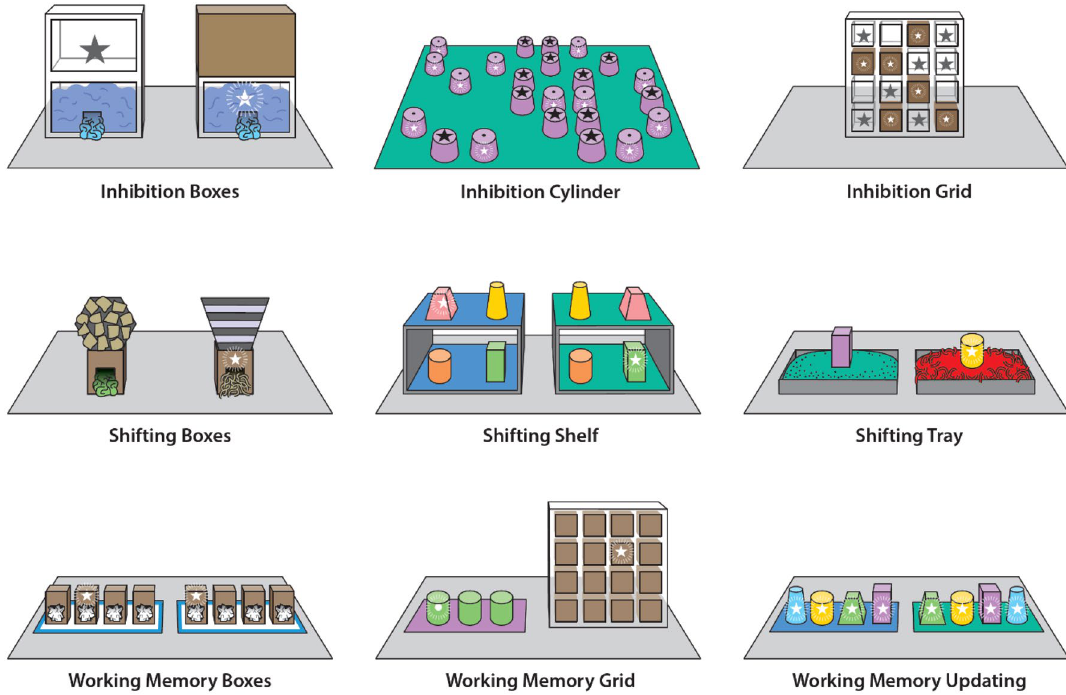
Figure 1. The nine executive functions tasks administered. In the Inhibition tasks, subjects were supposed to choose an opaque container (box, cylinder, or grid cell) with a non-visible reward over a transparent one with a visible but inaccessible reward. In the Shifting Boxes and Shifting Tray tasks, subjects were required to overcome a fixation on a previously relevant stimulus dimension and focus on another dimension. In the Shifting Shelf task, subjects had to switch between two different target cups depending on the context (i.e., the shelf they were choosing from). The WM Boxes and WM Grid tasks required subjects to remember the location of a reward over a short period in which they faced interference from a secondary task. In the WM Updating task, subjects had to remember their previous choices to determine which cups still contained a reward while alternating between two identical sets of cups.